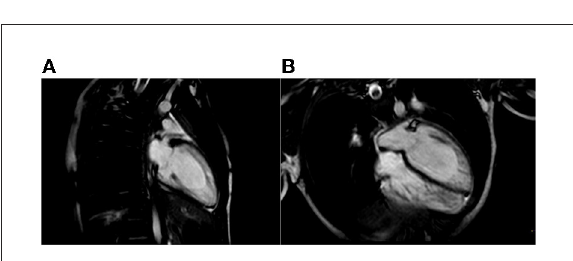
FIGURE3 Cardiac Magnetic Resonance end-diastolic 2-chamber (A) and 4-chamber (B) SSFP cine view showing an increased trabecular/compacted wall thickness